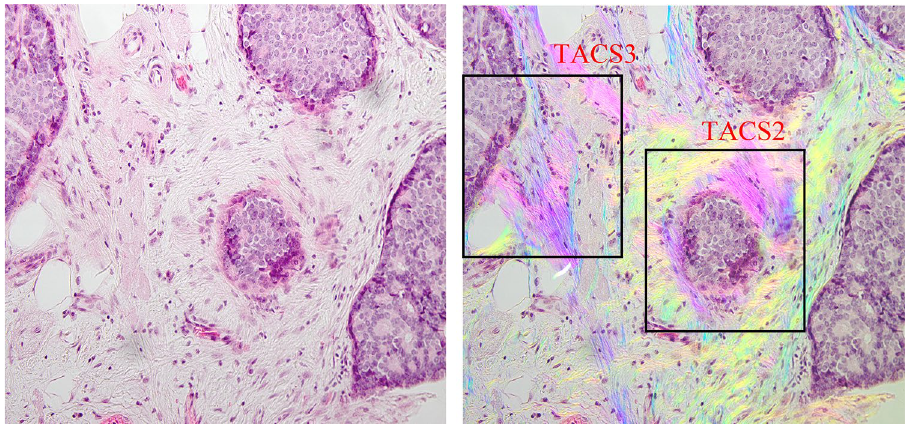
Figure 3. TACS-2 and -3 are both present in this figure. These collagen fibers are easily identifiable in the PPM image (right) by a color contrast compared to other tissue parts, the highly aligned fibers are also seen with similar hue (purple) that are perpendicular to tumor boundary in TACS-3 region and tangential to tumor boundary in TACS-2 regions, while none of these information can be readily extracted from the BF image only. The tissue area represented in images is 692 × 519